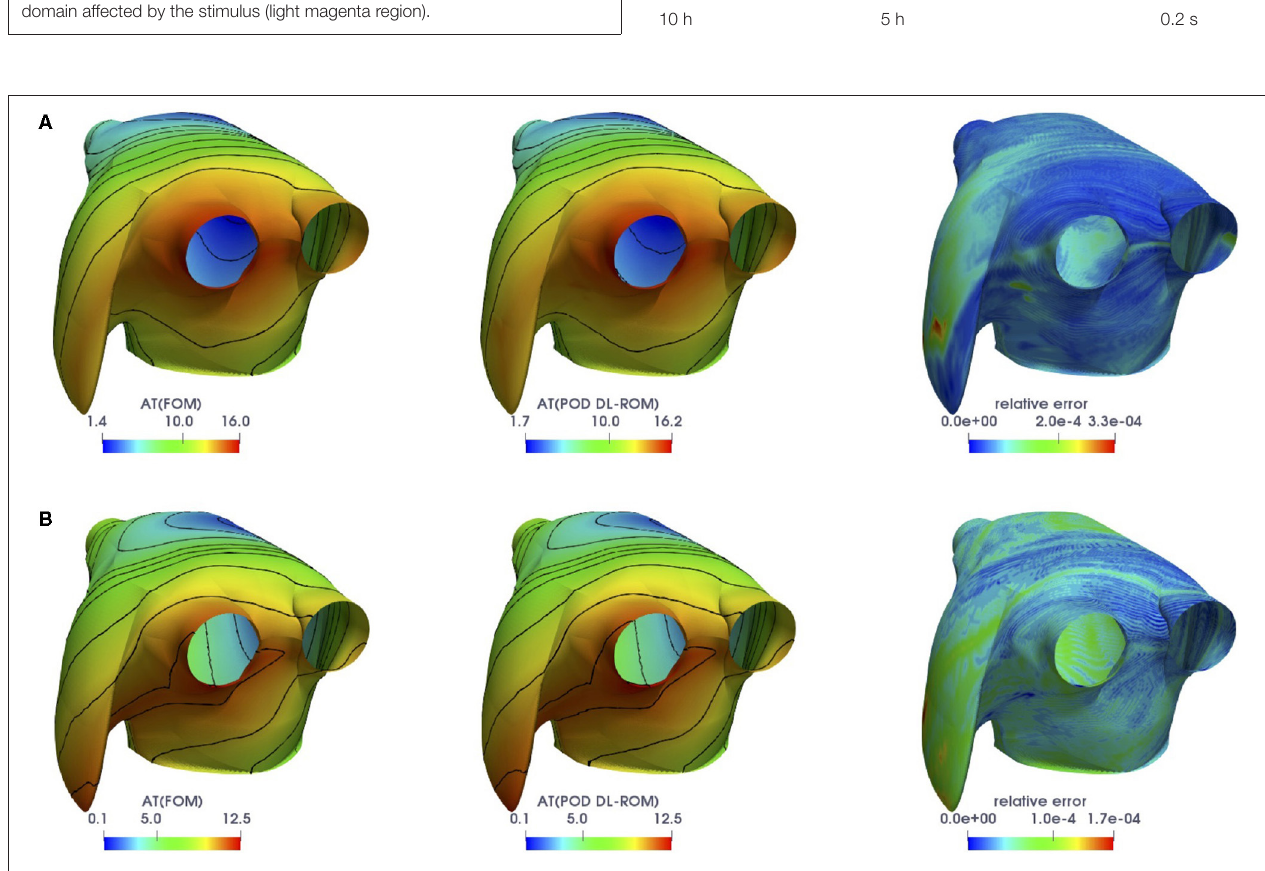
FIGURE 8 | Test 3 : FOM (left) and POD-DL-ROM (center), with n = 4 and N = 256, ACs and relative error ǫ k (right), for the testing-parameter instances µ test = (1.7168, − 0.353198, − 1.70097) cm (A) and µ test = (1.43862, − 0.803806, − 1.43678) cm (B)